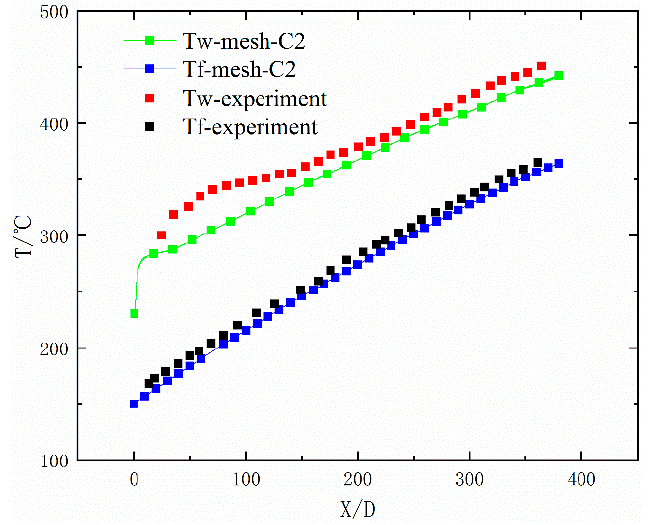
Figure 6. Comparison of the numerical and experimental results of downward flow. In addition to verifying the effectiveness of the numerical simulation, the mesh sensi- tivity must be evaluated. In this work, case A is adopted to evaluate the mesh sensitivity. The mass-weighted average temperatures of outlet 1 and outlet 2 are used as evaluation pa- rameters of the mesh sensitivity. Three sets of meshes of different densities are considered. The simulation results for these three sets of meshes are listed in Table 1. Table 1. Simulation results for the three sets of meshes. Mesh Number